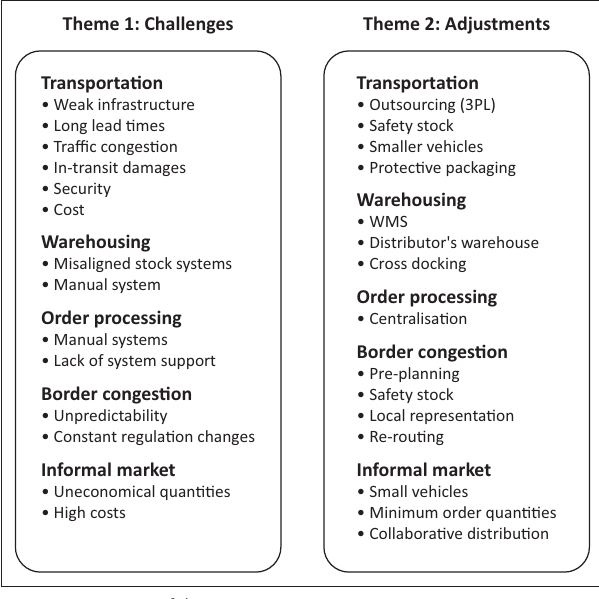
FIGURE 1: Summary of